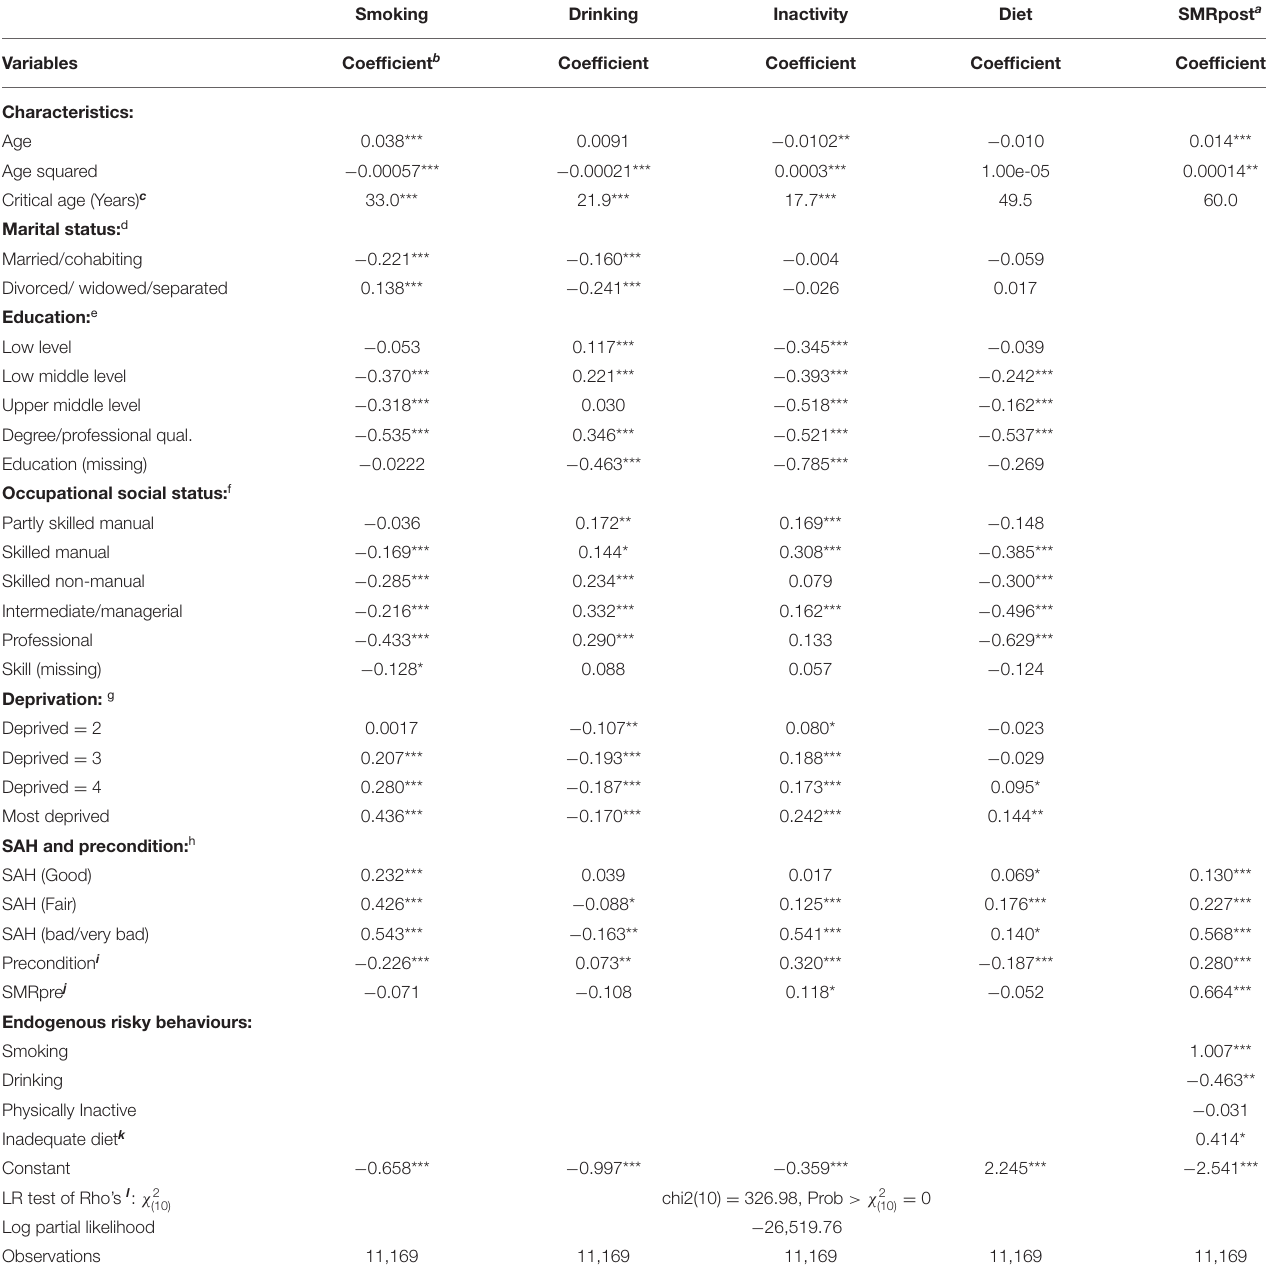
TABLE 3 | Recursive multivariate probit regression: